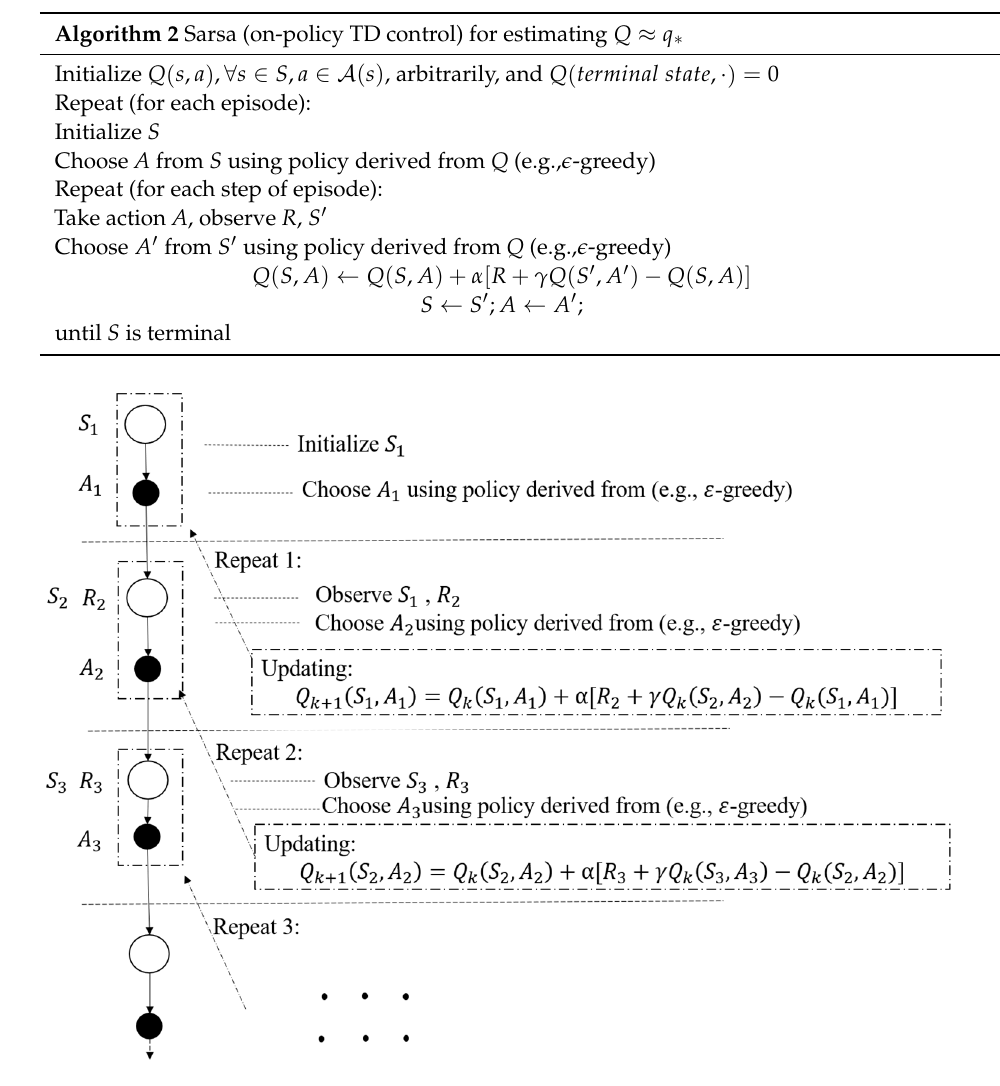
Figure 14. The SARSA algorithm procedure.